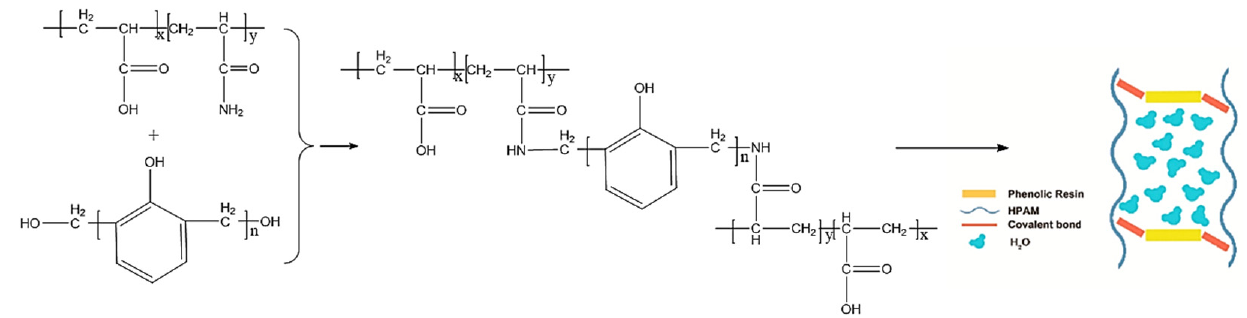
Figure 4. Crosslinking mechanism of phenolic resin. (Reprinted/adapted with permission from Ref. [34], 2020, Zhang et al.).